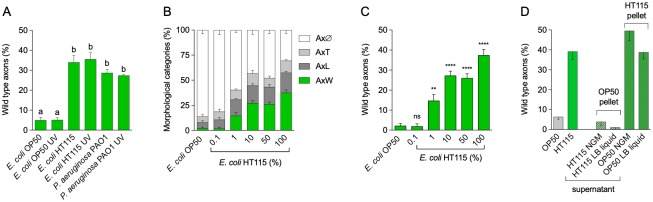
Bacterial components have neuroprotective activity.(A) Axonal categories in worms raised in the indicated live or UV-killed bacterial strains. (B–C) All axonal categories (B) or wild-type (C) axons in worms rose in different proportions of UV-killed E. coli HT115 on UV-killed OP50. (D) Wild-type axons of mec-4d animals fed with E. coli HT115 or OP50 bacterial pellet supplemented with supernatant of OP50 or HT115. ****P < 0.0001, ***P < 0.001, **P < 0.005, *P <0.05; ns. “a” and “b” are used to indicate statistically significant differences. The underlying numerical data and statistical analysis for each figure panel can be found in S1 and S2 Datasets, respectively. Axϕ, degenerated axon; AxT, truncated axon; AxW, wild-type axon; LB, Luria-Bertani; mec-4d, mechanosensory abnormality protein 4; NGM, nematode growth media; ns, not significant.